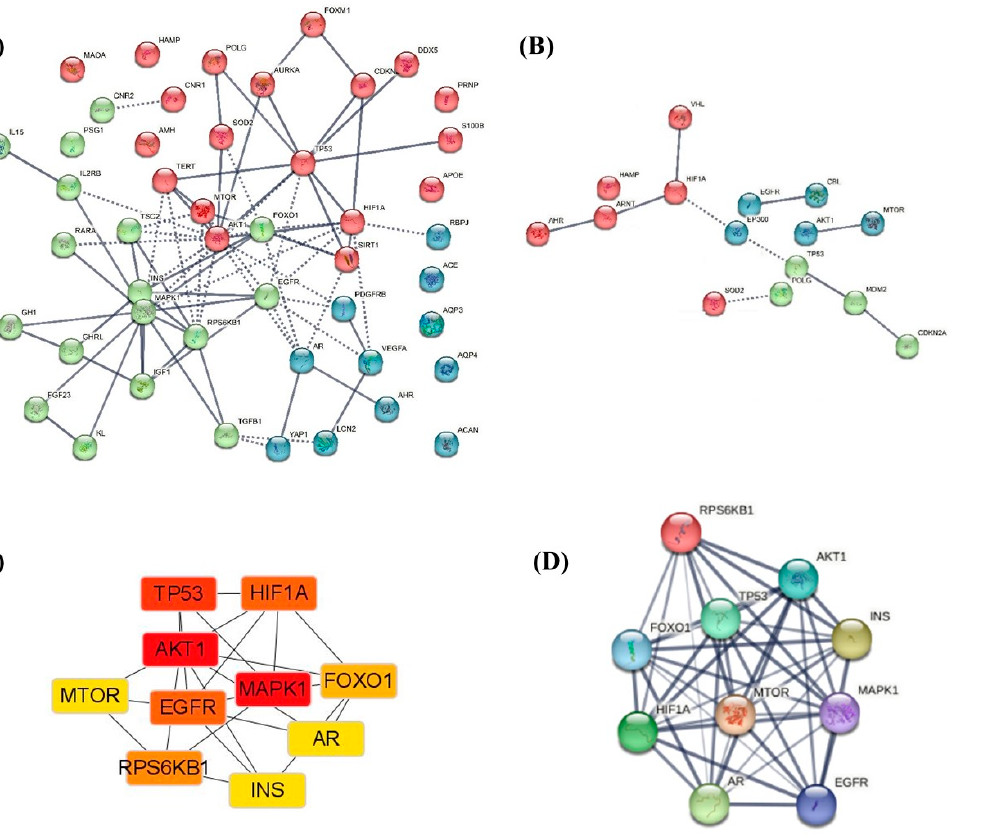
Figure 2. The key genes of endocrine glands aging and the protein-protein interaction (PPI) network. ( A ) The PPI network of the aging endocrine glands genes. Using the STRING online database, 44 genes were selected and used to construct the PPI network. ( B ) The PPI network of the signi fi cant genes by experiment. ( C ) The top 10 signi fi cant genes. ( D ) The PPI network of the top 10 genes.